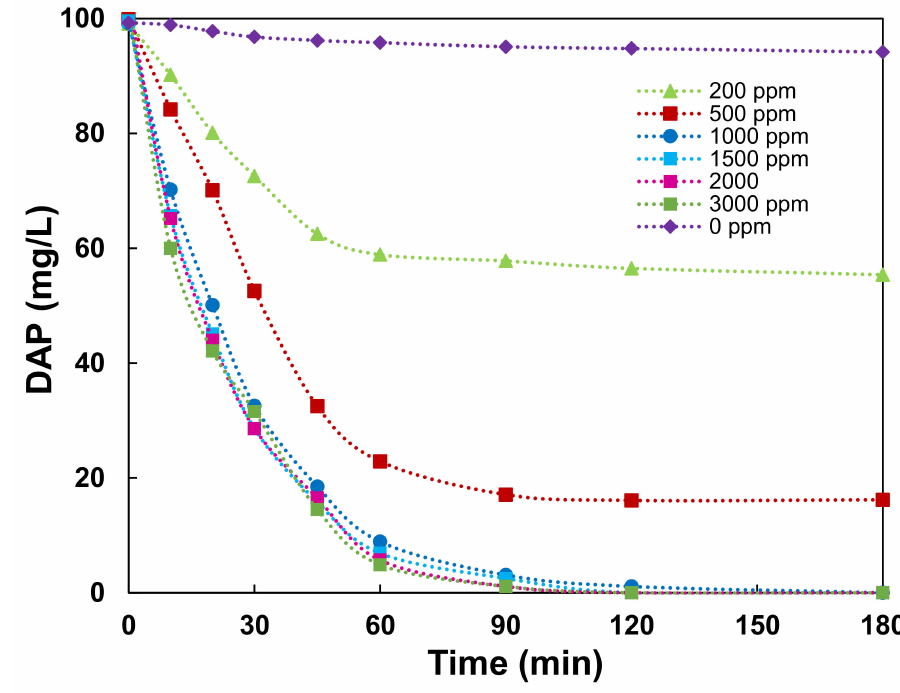
Figure 5. Effect of H 2 O 2 concentration on the DAP degradation kinetics during the Fenton process (H 2 O 2 /Fe 2+ ). Experimental conditions: [DAP] 0 = 100 mg/L; [H 2 O 2 ] = 0–3000 mg/L; [H 2 O 2 ]/[Fe 2+ ] = 20; pH =